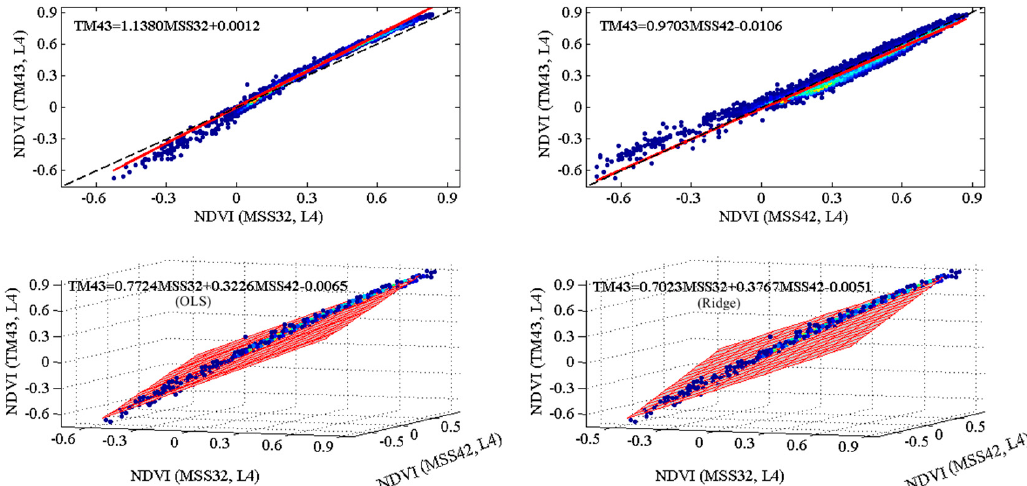
Figure 7. Demonstration of the transforming models to estimate the TM NDVI from the MSS NDVI of Landsat 4 (L4). Two univariate models are in the top row, in which the red lines show ordinary least squares (OLS) regression of the MSS NDVIs (MSS32 and MSS42) against the TM NDVI (TM43) respectively, while the dashed lines are 1:1 lines superimposed for reference. The bivariate models through OLS regression and ridge regression respectively are in the bottom row, in which the planes with red edge show regression models. Similar as in Figure 3, the color from blue to red is representing the data density from low to high.